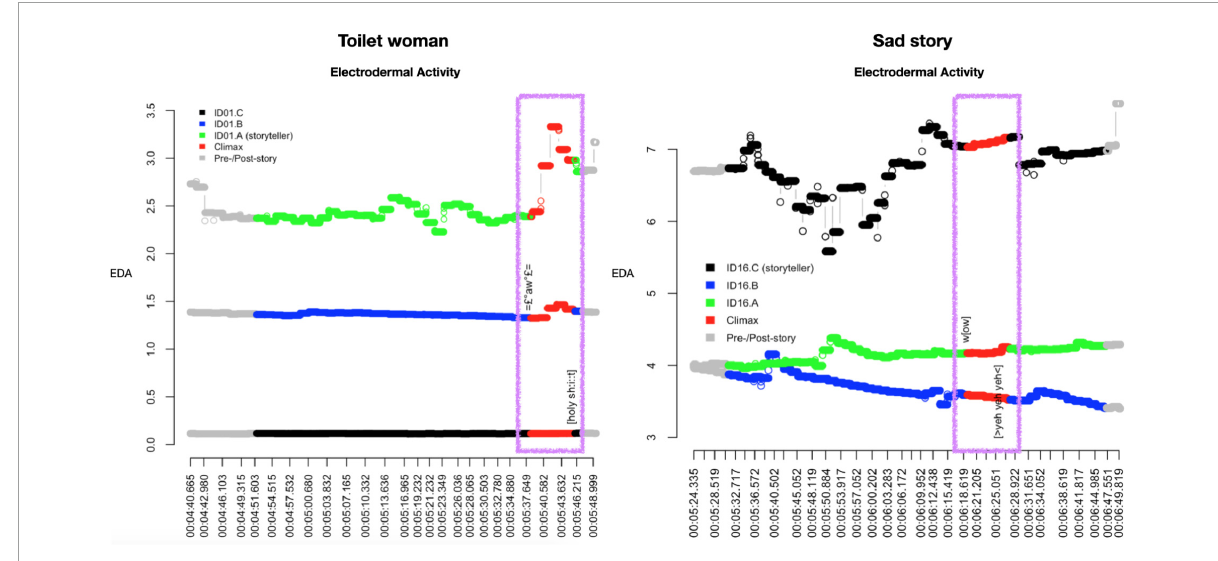
FIGURE3 Scatter plots of EDA responses by participants in storytelling “Toilet woman” (left panel) and storytelling “Sad story” (right panel) .